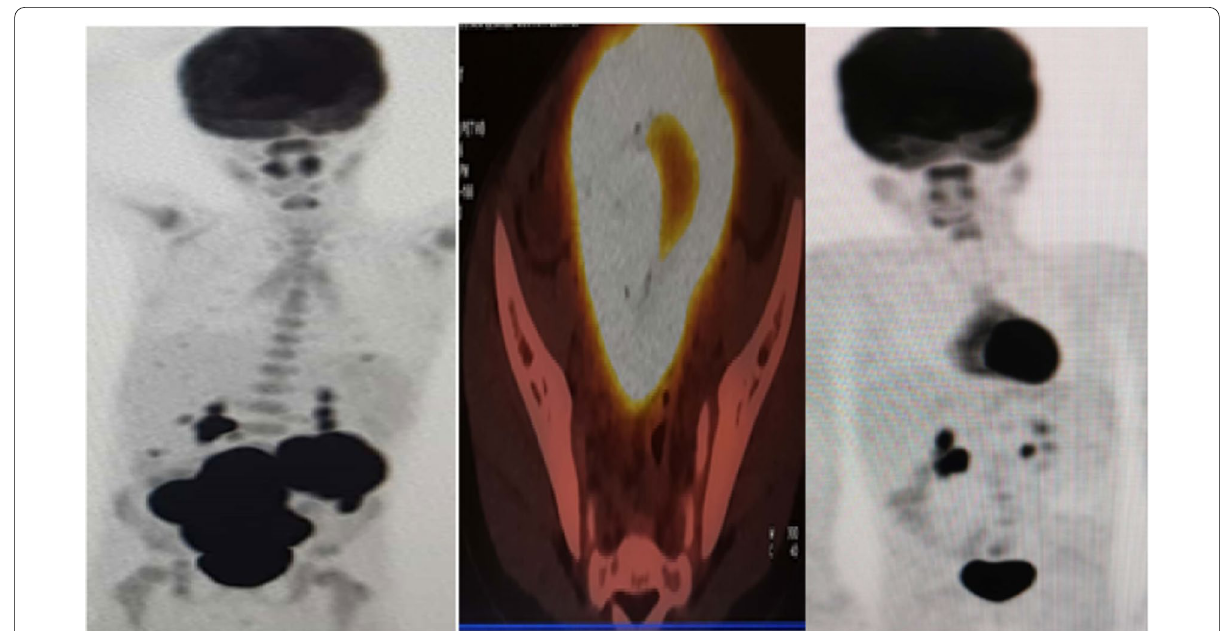
Fig. 7 PET‑CT study for a 5‑year‑old male child presented with an abdominal mass. To the left: Initial study shows metabolically active FDG‑avid abdomino‑pelvic bowel mass. The mid image: Fused PET‑CT image shows FDG‑avid abdomino‑pelvic bowel mass with marked mucosal thickening. To the right: Interim PET‑CT study shows complete disappearance of all lesions. Both visual and semiquantitative interpretation methods were negative, and the patient was free till the last